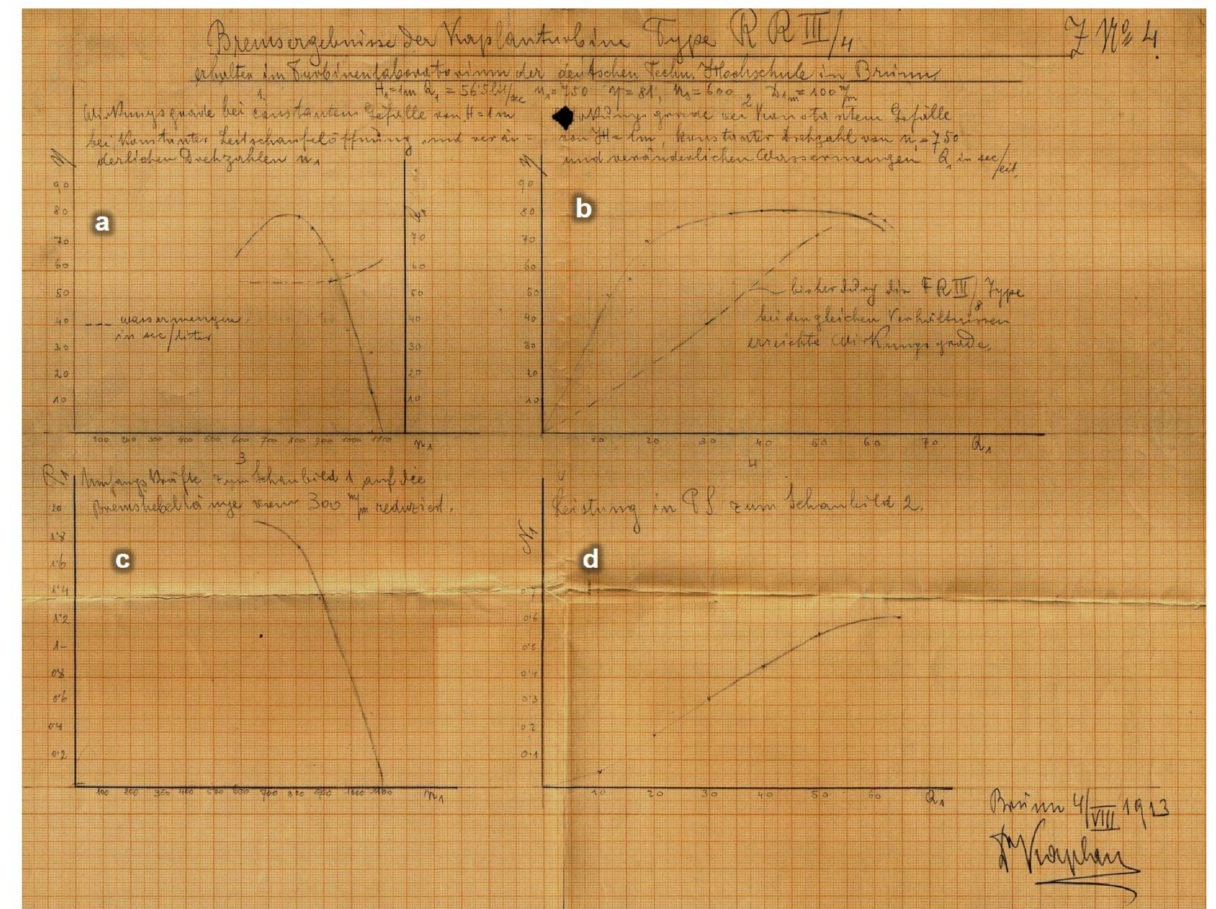
Figure 9. Original record of laboratory tests of the Kaplan turbine. Translation of the comments: Brake tests of Kaplan turbine type RR III/4 obtained in the turbine laboratory of the German Technical University in Brno H = 1 m; Q1 = 56.5 lit/sec; n1 = 750 min − 1 ; η = 81%; ns = 600 min − 1 ; D1m = 100 mm. ( a ) Efficiency at constant head H = 1 m, constant blade opening and variable speed, ( b ) efficiency at constant head, constant speed and variable flow (dashed line: impeller efficiency FR III/8 measured under the same conditions), ( c ) peripheral force on the brake reduced to an arm length of 300 mm, ( d ) power output in HP for diagram 2 (here marked ( b )). Source: